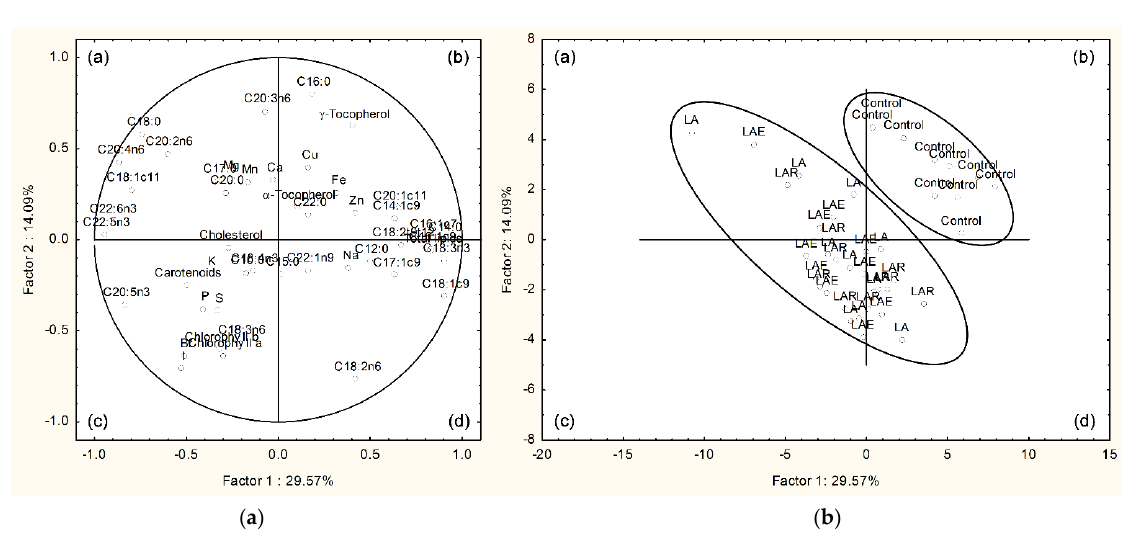
for factor 1, and 16:0, 18:0, 18:2n-6, 18:3n-3, and 22:1n-9, for factor 2 (Table S1).